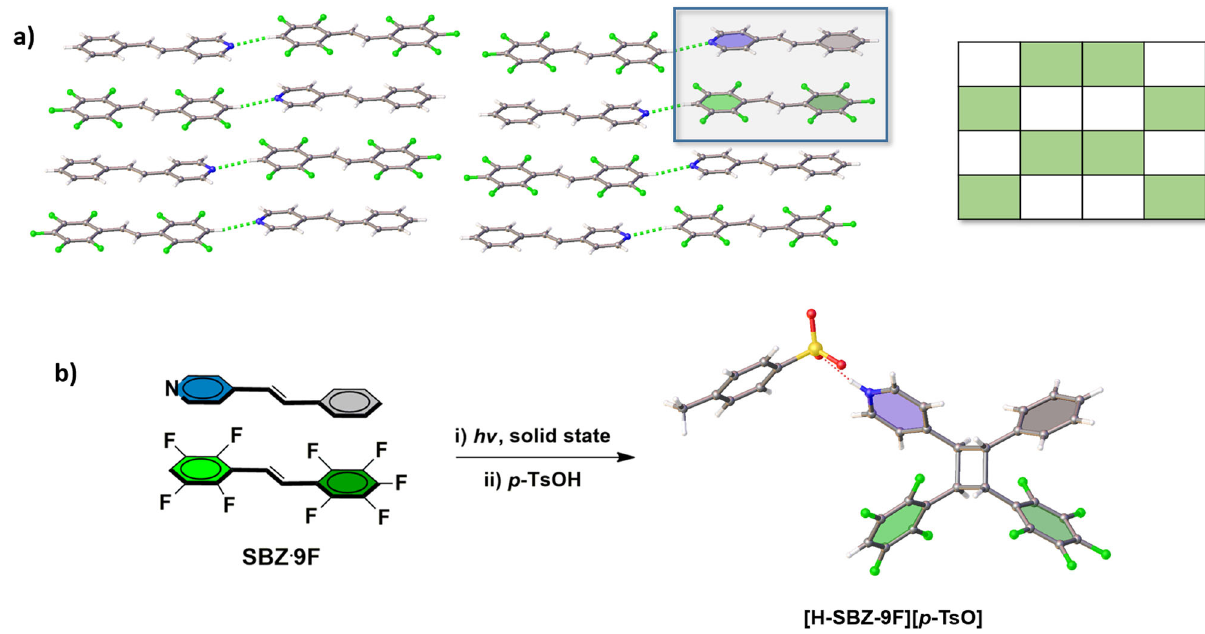
Fig. 7 Cross-photoreaction showing X-ray structures. a SBZ ˑ 9F (inset: representation of packing type), b [ H-SBZ-9F-cb ][ p - TsO ] with solid-state photoreaction and isolation as salt highlighted. Note four different groups present on cyclobutane ring system.